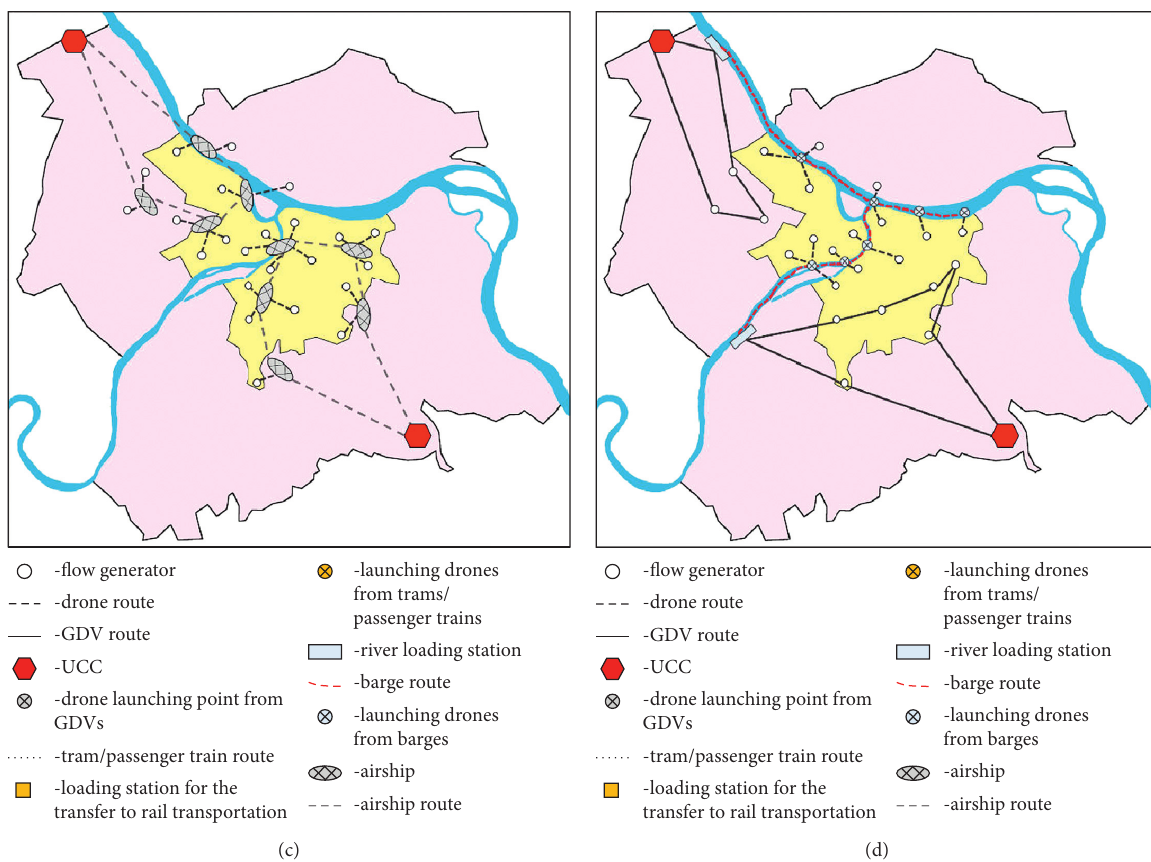
Figure 2: CL concept 2: goods delivery with mobile depots and drones. (a) GDVs as mobile depots; (b) trams/passenger trains as mobile depots; (c) airships as mobile depots; (d) barges as mobile depots.